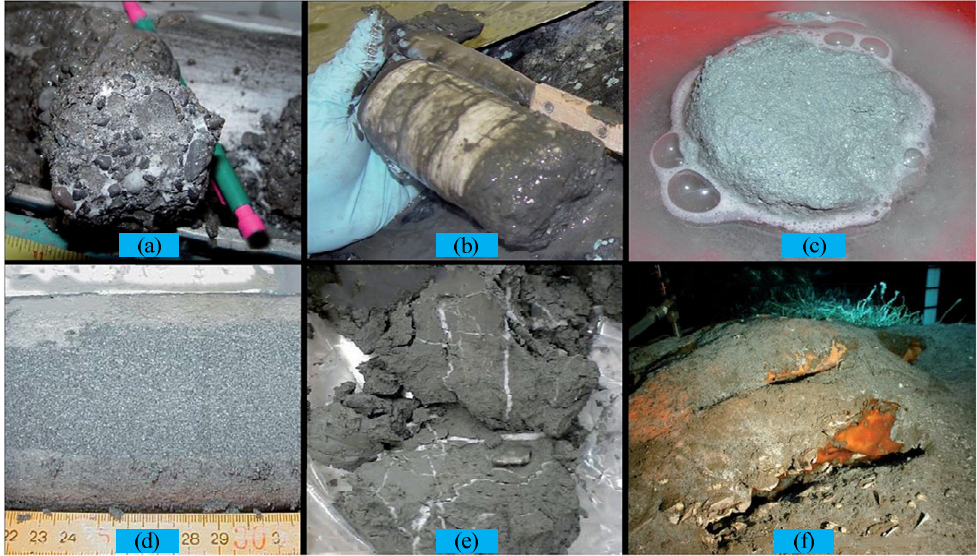
Figure 3. Occurrence characteristics of NGHs [6]. ( a ) Contained in the pore spaces of coarse-grained sand; ( b ) Massive lenses and nodules in muds; ( c ) Disseminated in muds; ( d ) Contained in the pore spaces of fine-grained marine sand; ( e ) Thin veins in muds; ( f ) Massive mounds on sea-floor.